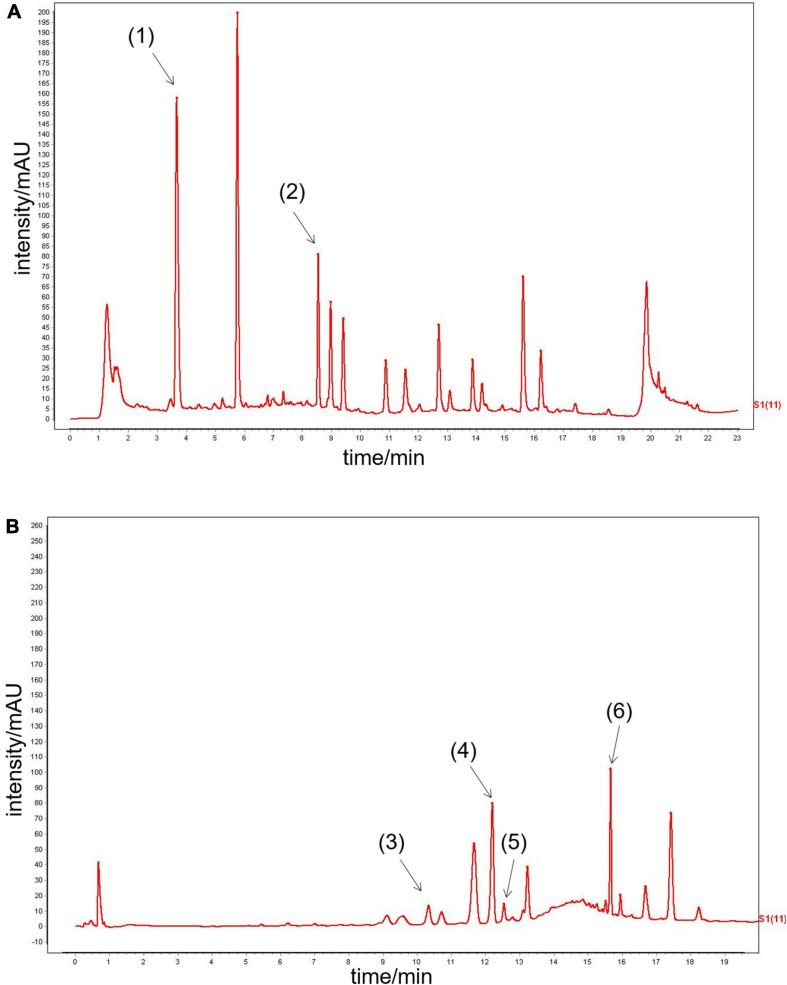
UPLC analysis of QYDP. (A) (1) salvianic acid, (2) calycosin glycoside, (B) (3) notoginseng R1, (4) Ginsenoside Rg1, (5) Ginsenoside Re, and (6) Ginsenoside Rb1.